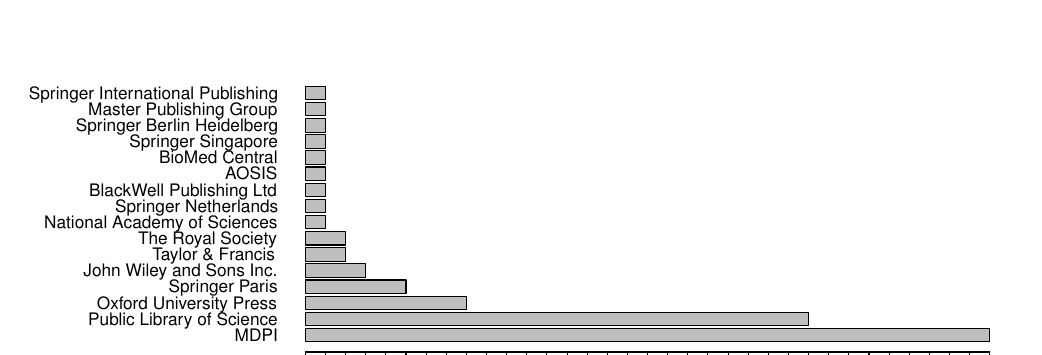
Figure 6. Number of articles per journal.